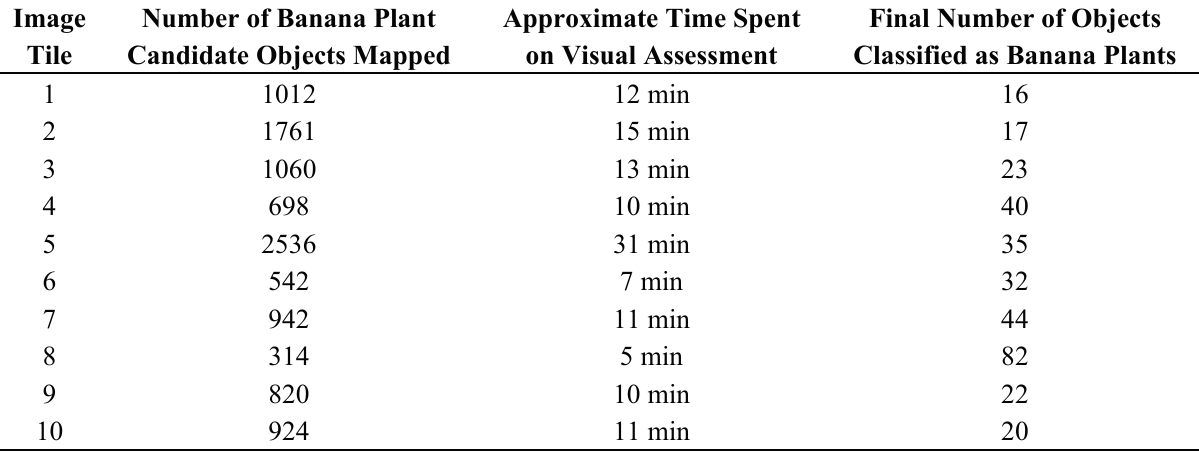
Table 5. Number of banana plant candidate objects mapped by the automatic mapping method and the subsequent time spent on the visual assessment to accept or decline the candidate